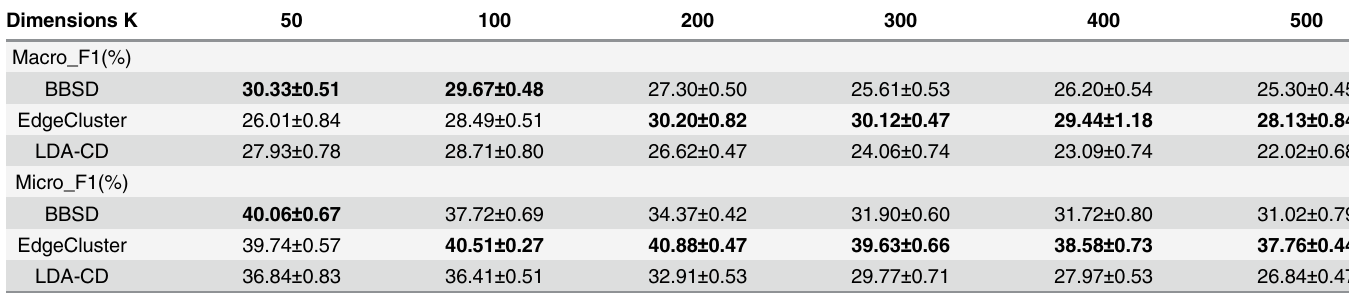
Table 8. Parameter sensitivity to social dimensions on YouTube (LP = 5%). Dimensions K